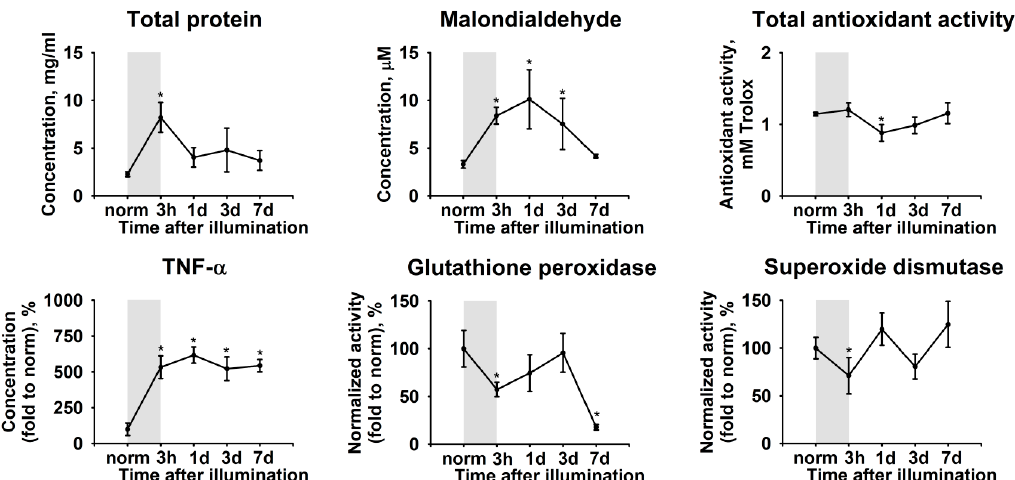
Figure 3. Alterations in biochemical properties of rabbit aqueous humor (AH) under conditions of LIRD. The animals were illuminated with intense visible light (30,000 lx) for 3 h (the course of the illumination is shown as gray box). AH samples were collected before (norm) and immediately after (3 h) the illumination as well as on 1, 3, and 7 day post-exposure. The samples were analyzed for total protein, tumor necrosis factor alpha (TNF- α ), and malondialdehyde content as well as total antioxidant activity (in Trolox equivalent) and activity of glutathione peroxidase and superoxide dismutase using the respective assays. * p < 0.05 as compared to parameters of AH of the intact (control) animals.